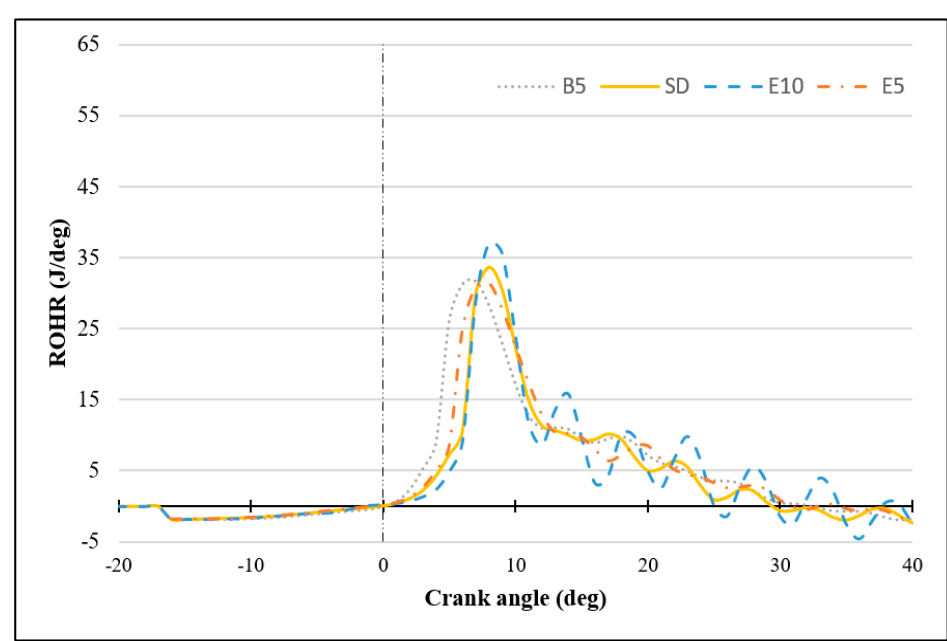
Figure 14. Comparison of the ROHR at 2 kW for various fuels.